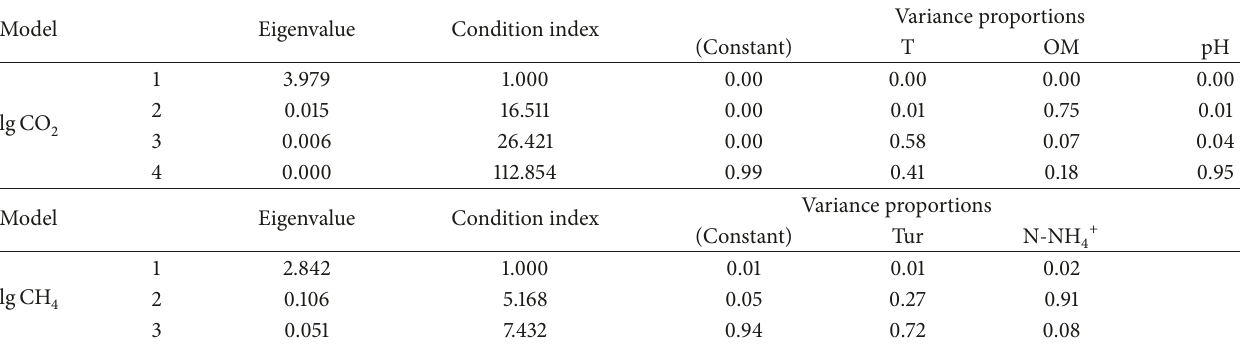
Table 6: Collinearity diagnostics.